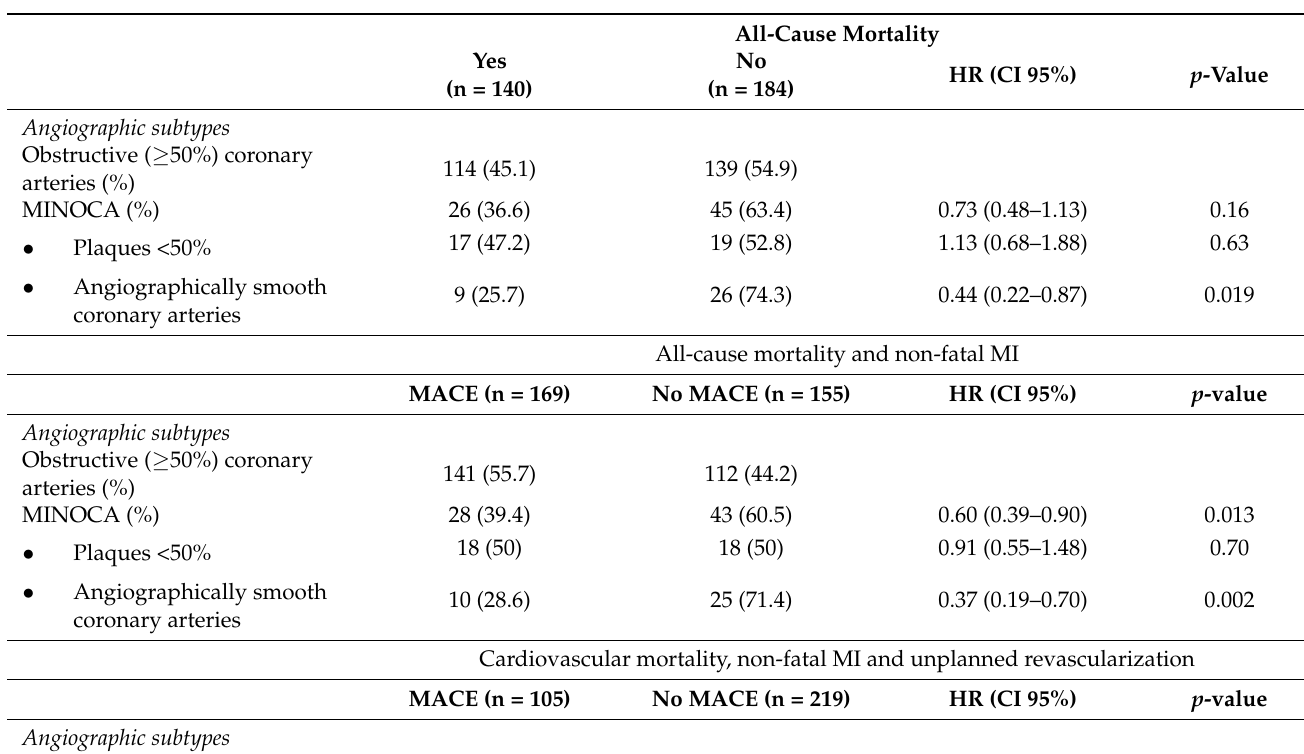
Table 5. Impact of angiographic subtypes on the presence of all-cause mortality and MACE during follow-up. Univariate analysis. Univariate logistic regression.